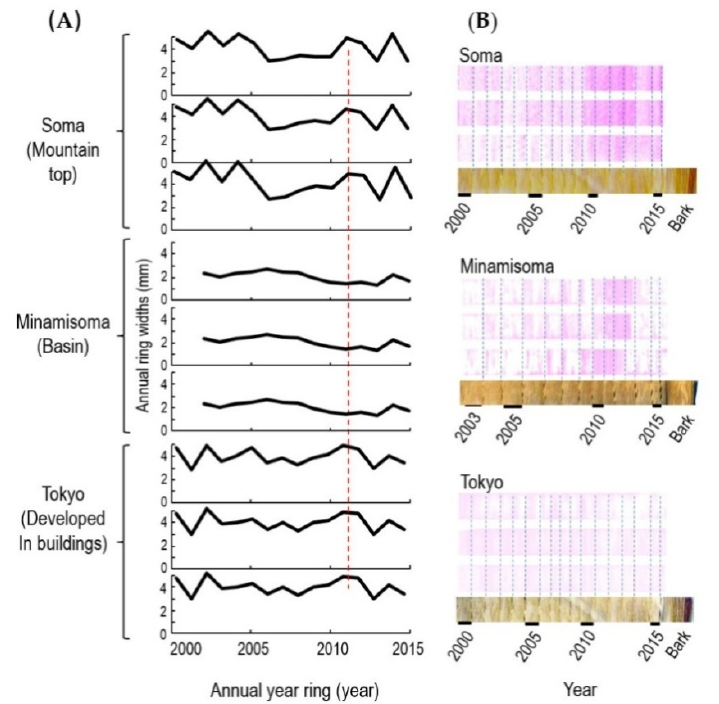
Figure 2. Annual rings of oak trees. ( A ) Annual growth-ring widths as measured in oak tree samples (Figure 1 and Table 1). Width values represent the mean of four sections of trunks. The dotted red line shows the year 2011. The oak trees sampled in Minamisoma were 15 years old, although others were more than 40 years old. ( B ) Immuno-staining of xyloglucan in the annual rings of oak trunks from different locations and environments. Tree ‐ ring sections were stained with antibody LM15 followed by a second antibody attaching a polymer with peroxidase.